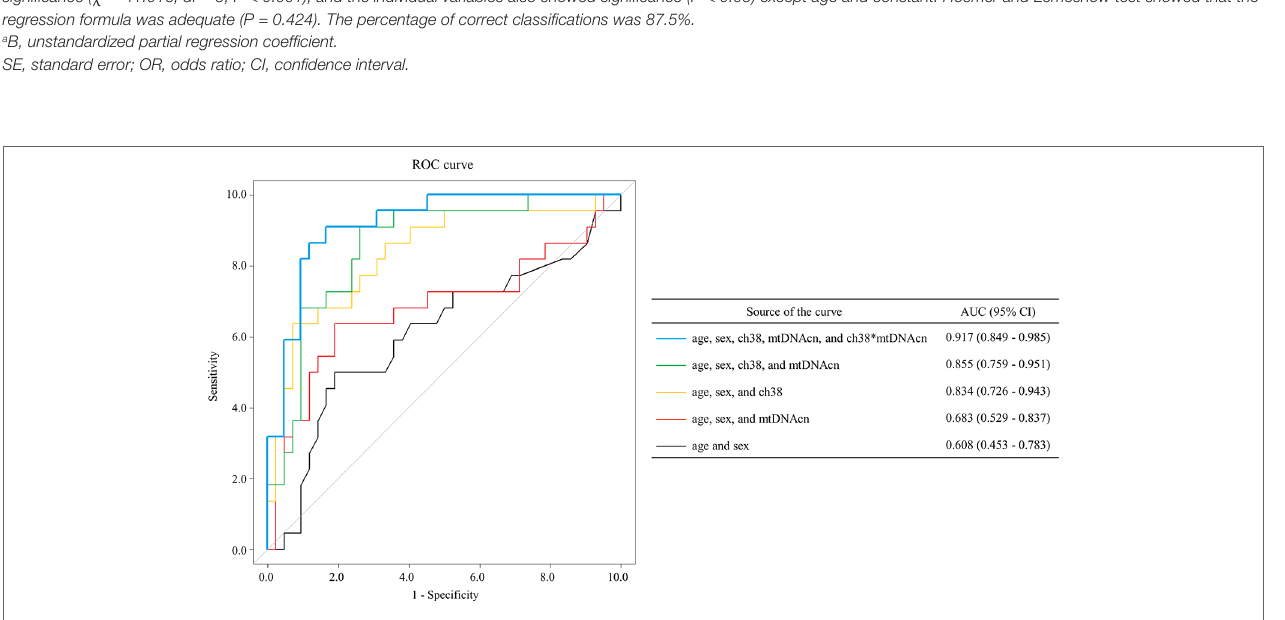
FIGURE 4 | The receiver operating characteristic curves from multivariate logistic regression models. Multivariate logistic regression analysis [the response variable: phenotype (bipolar disorder, BD/major depressive disorder, MDD) using the explanatory variables age, sex, VFT-related oxy-Hb changes for channel 38, mitochondrial DNA copy number (mtDNAcn), and interaction between mean VFT-related oxy-Hb changes of ch38 and mtDNAcn] showed high accuracy [area under the curve (AUC) = 0.917 (95% CI = 0.849–0.985)].